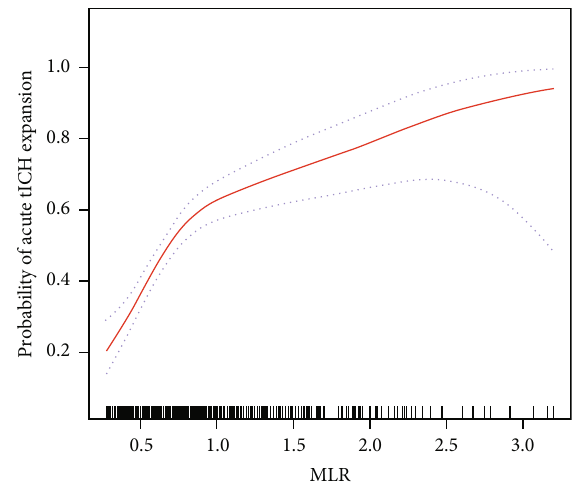
Figure 3: The relationship between MLR and acute tICH expansion a . a Adjusted for sex, age, coagulopathy, subdural hemorrhage, time to baseline CT time, baseline tICH volume, and location of